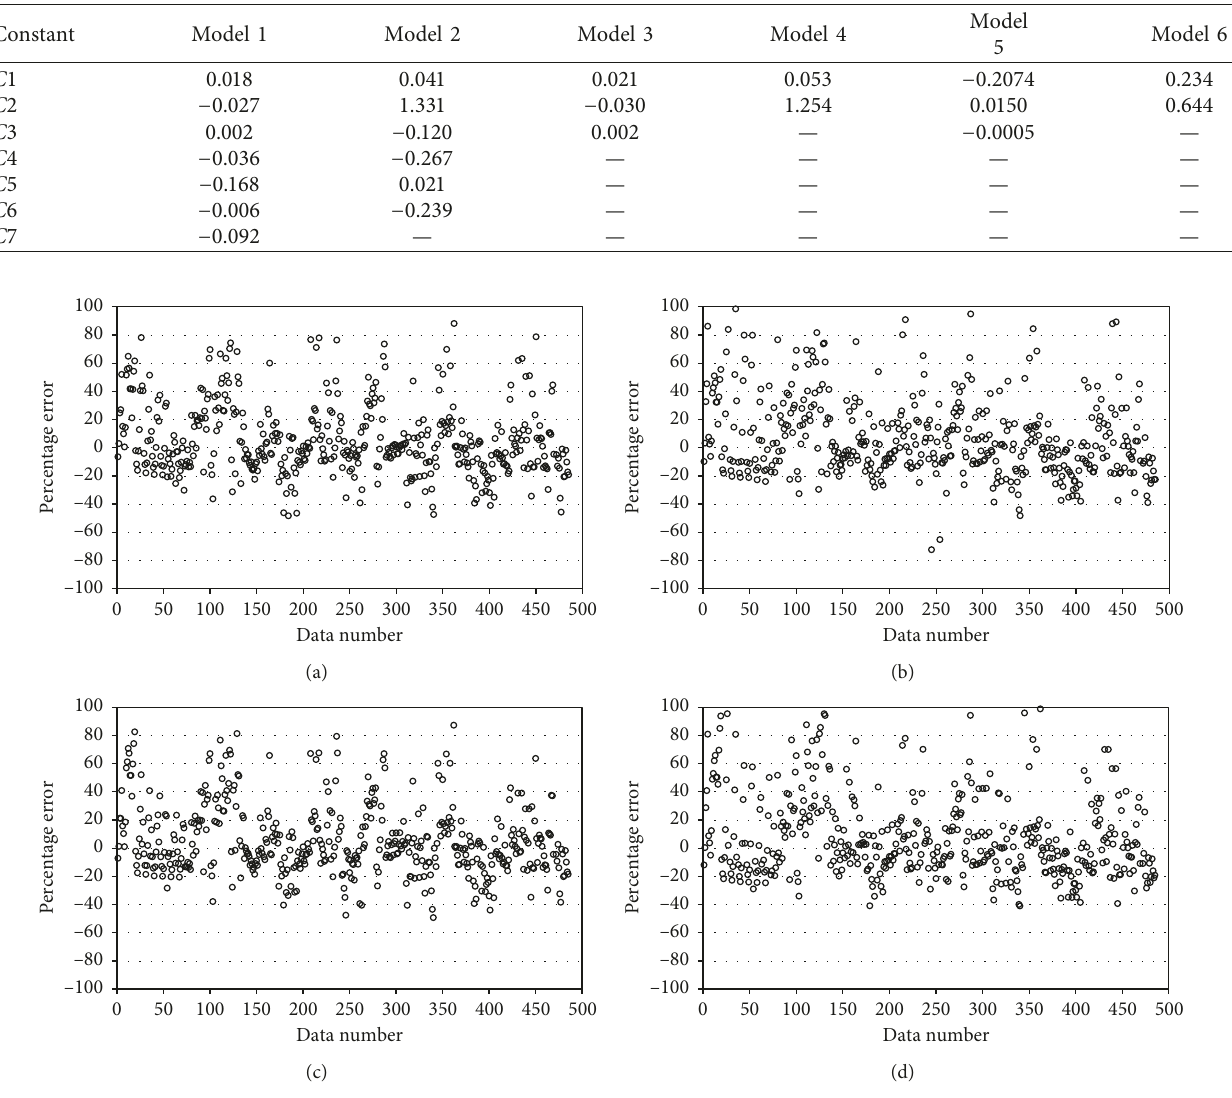
Table 5: Values of constants C 1 to C 7 for the proposed regression models.